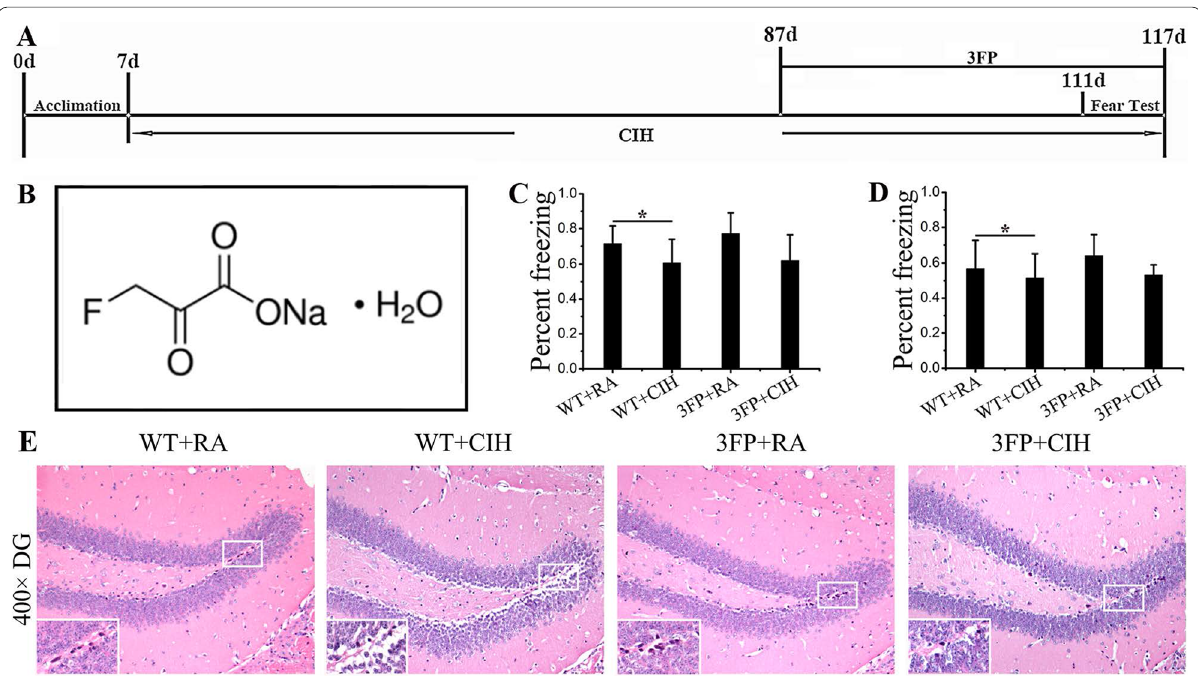
Fig. 7 Affecting the pathway of PDP1/PDHA1 did not improve the damage caused by CIH exposure. A The study workflow. After 7 days of acclimation, the mice were exposed to the CIH condition for about 3 months, and they were treated with 3-FP at the last 3 weeks. Fear test were conducted as soon as CIH exposure finished. B The structure of 3-FP. C The freezing level of contextual memory among 4 groups. D The freezing level of cued memory among 4 groups. E H&E stained of the hippocampus. Each experiment was repeated three times. Data are shown as the mean SEM. Statistical analysis was performed with two-way ANOVA. *p < 0.05 WT group vs WT CIH group. Magnification: 400 ± are enlarged in the rectangular frame